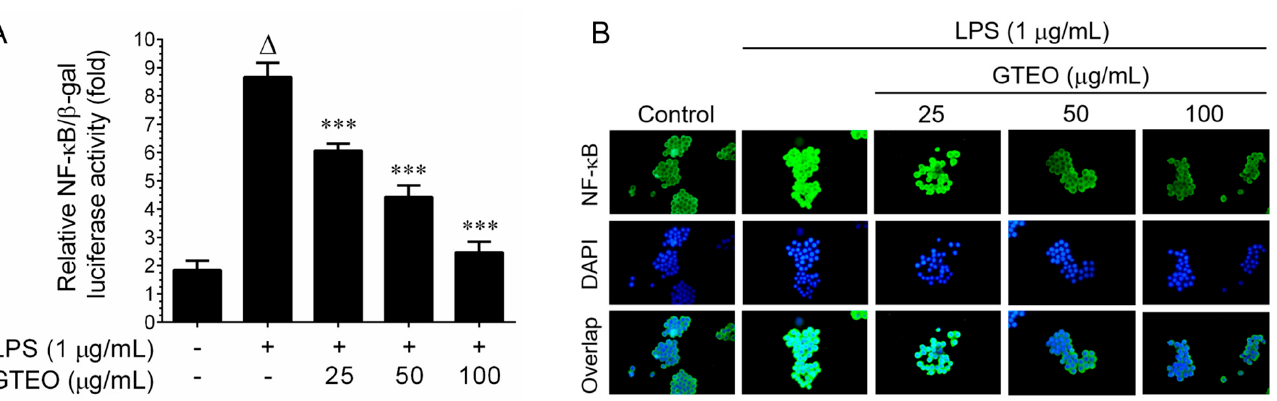
Figure 4. Effect of GTEO on LPS-induced I- κ B α instability followed by activation of IKK α . RAW 264.7 cells were stimulated with LPS (1 μ g/mL) and incubated in the presence or absence of